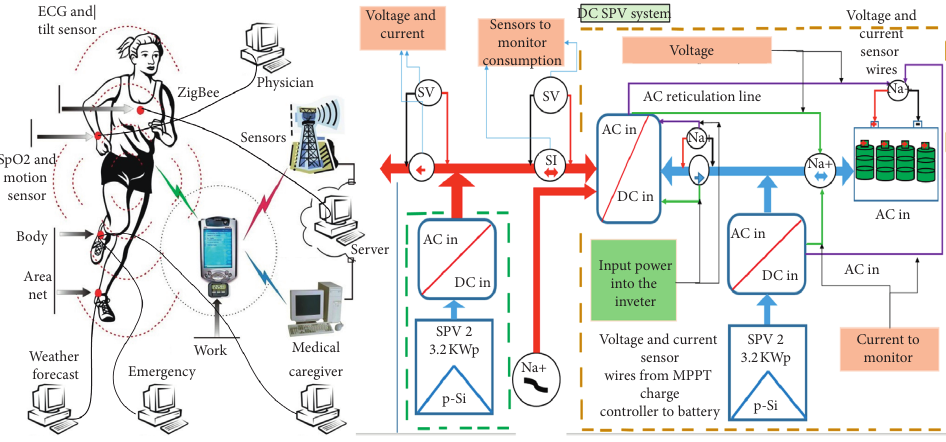
Figure 2: Sensor information gain algorithm